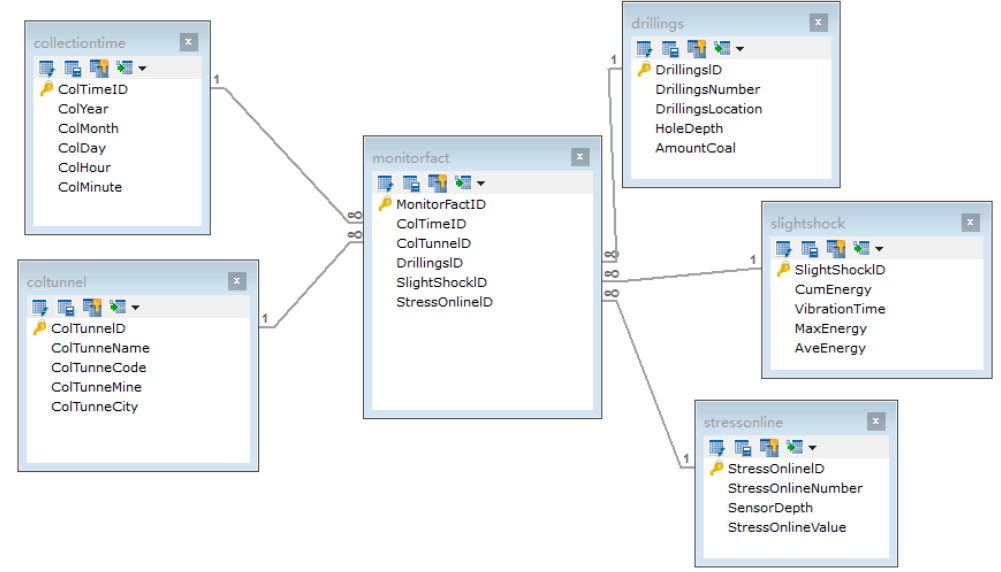
Figure 4. HAB_AP star data model.